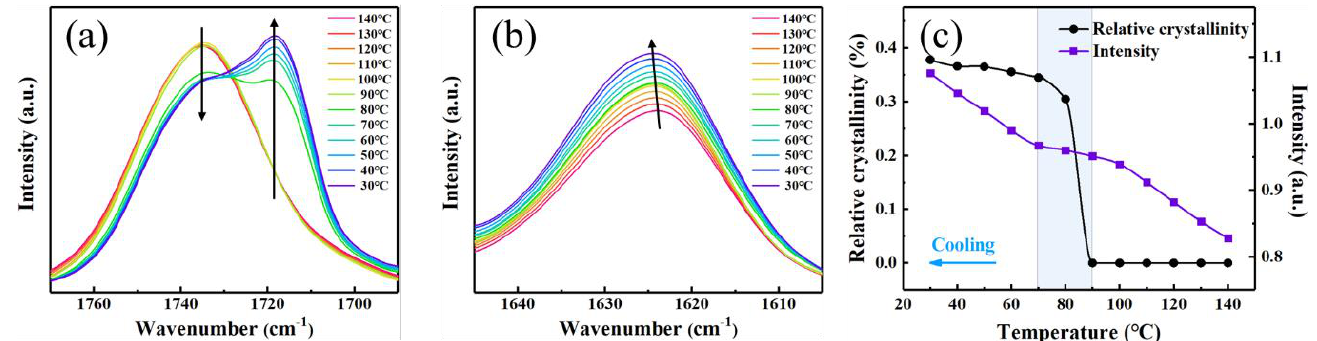
Figure 9. In situ FTIR spectra of PBSAD-14 during melt cooling process at ( a ) wavenumbers from 1780 cm – 1 to 1690 cm – 1 , and ( b ) from 1645 cm – 1 to 1605 cm – 1 . ( c ) The dependences of relative crystallinity of PBSAD-14 and absorption intensity of C=O stretching vibration in AD units are plotted as function of temperature during melt-cooling.